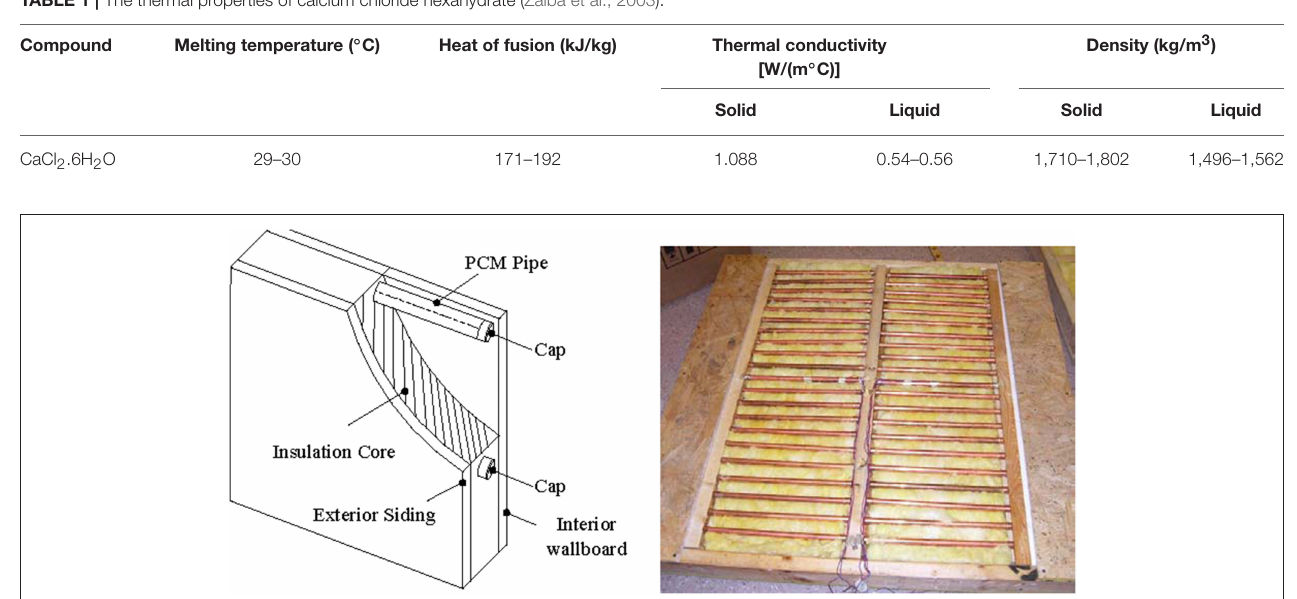
FIGURE 1 | Schematic of PCM encapsulation and